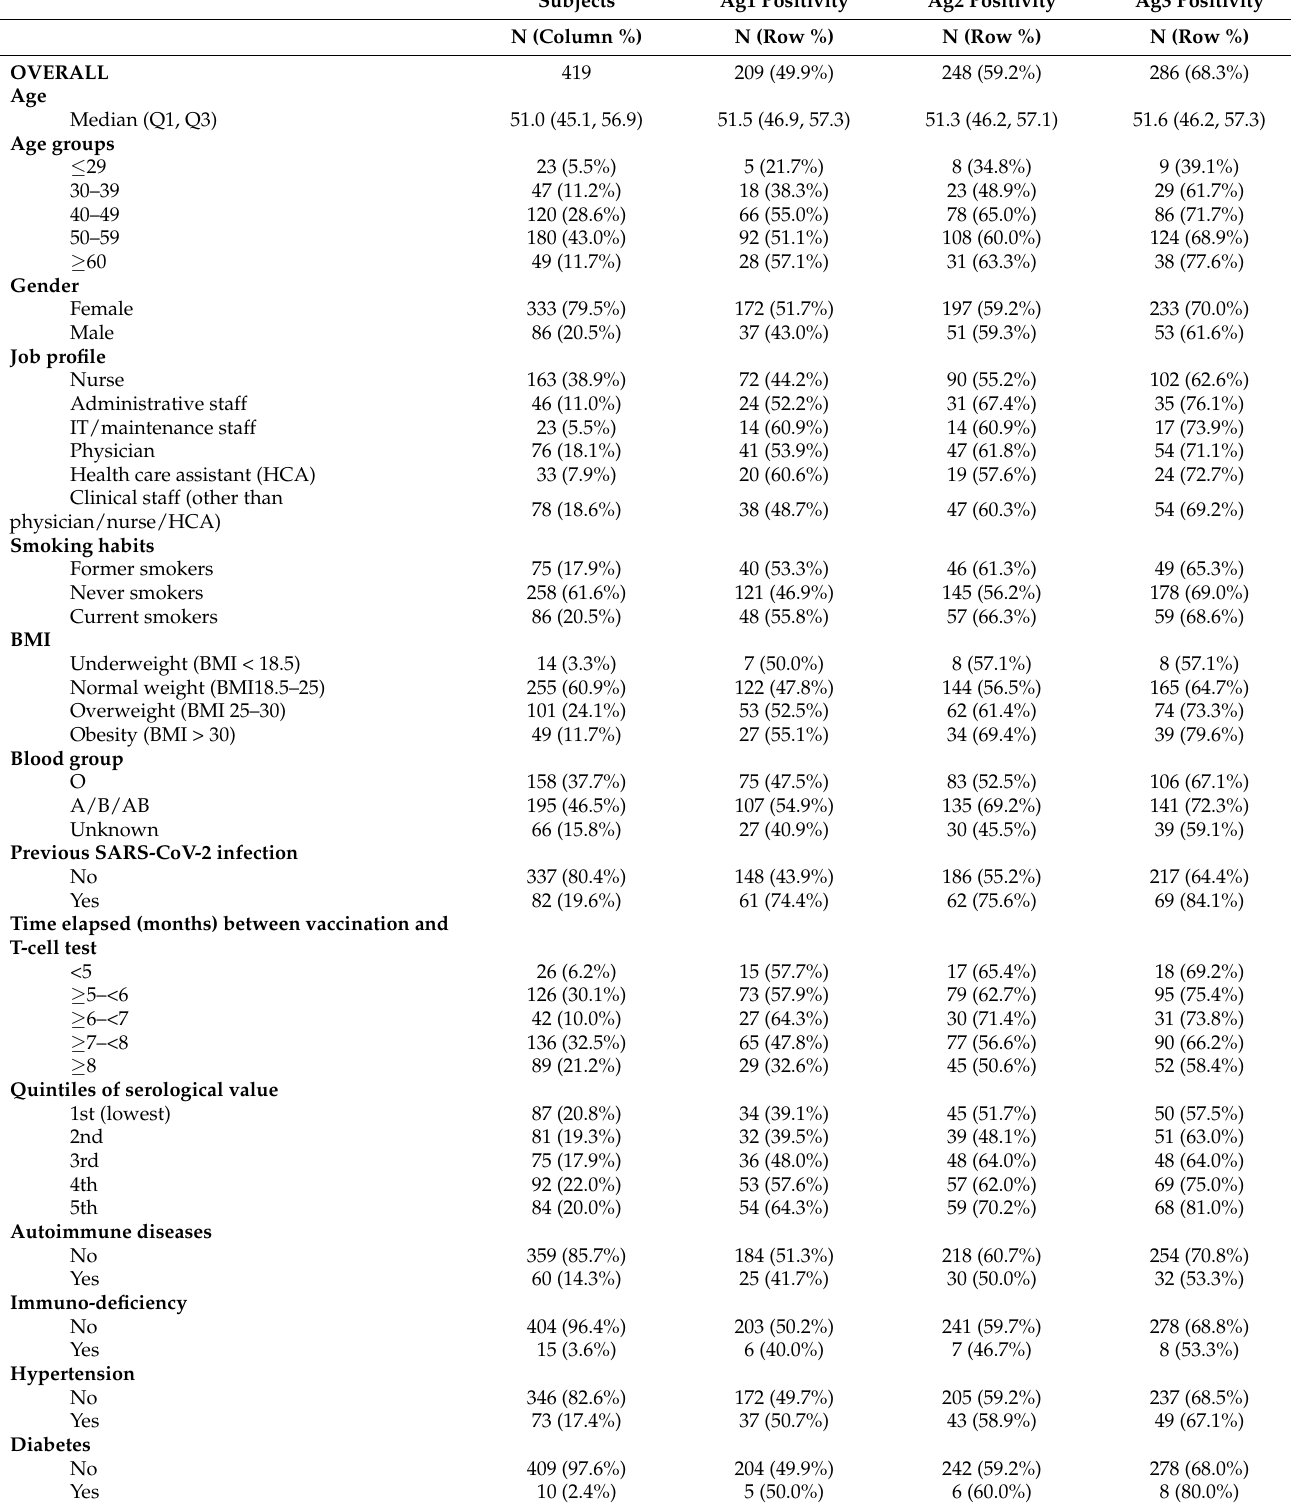
Table 1. Subjects included in the study (second column from the left) and prevalence of positivity for each antigenic stimuli (Ag) (three rightmost columns) among 419 vaccinated HCW of CSS, by subjects’